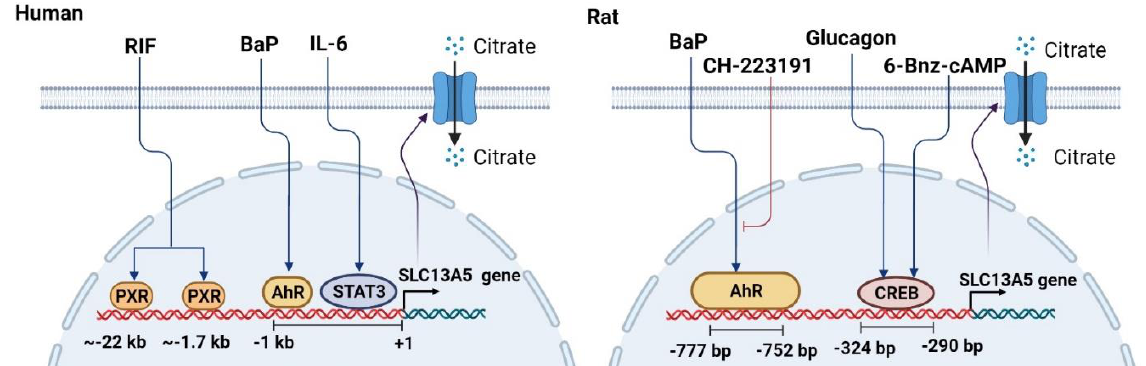
Figure 3. Schematic illustration of the mechanisms underlying the transcriptional regulation of SLC13A5. Transcription factors including PXR, AhR, CREB, and STAT3 can positively regulate the transcription of SLC13A5 in the liver upon exposure to their activators such as RIF, BaP, glucagon, and IL-6, respectively. Specific response elements (motifs) that can bind to these transcription factors have been identified upstream of the SLC13A5 gene in human and/or rodents. CH-223191 is an antagonist of AhR.